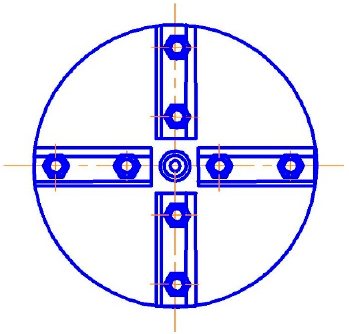
Figure 1. Disc cutting system of the chopper.